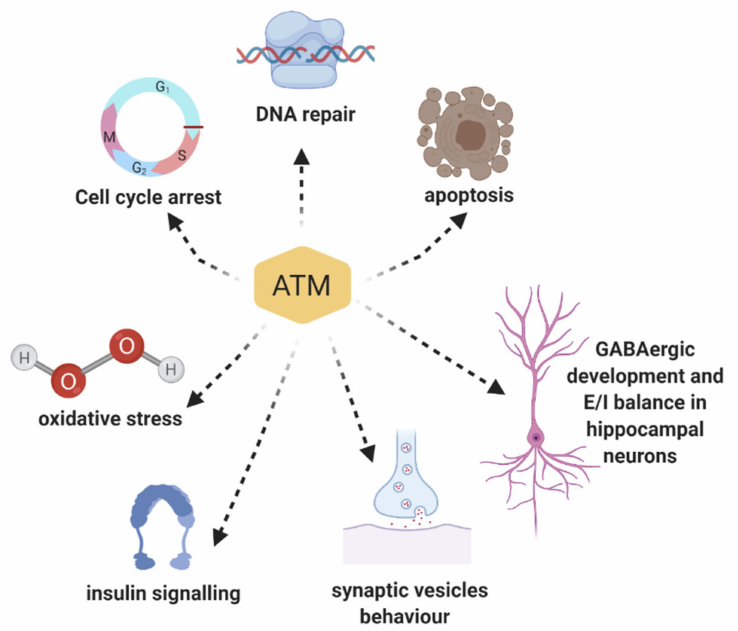
Figure 2. Scheme of the di ff erent roles of ATM. ATM plays di ff erent roles both in the nucleus and